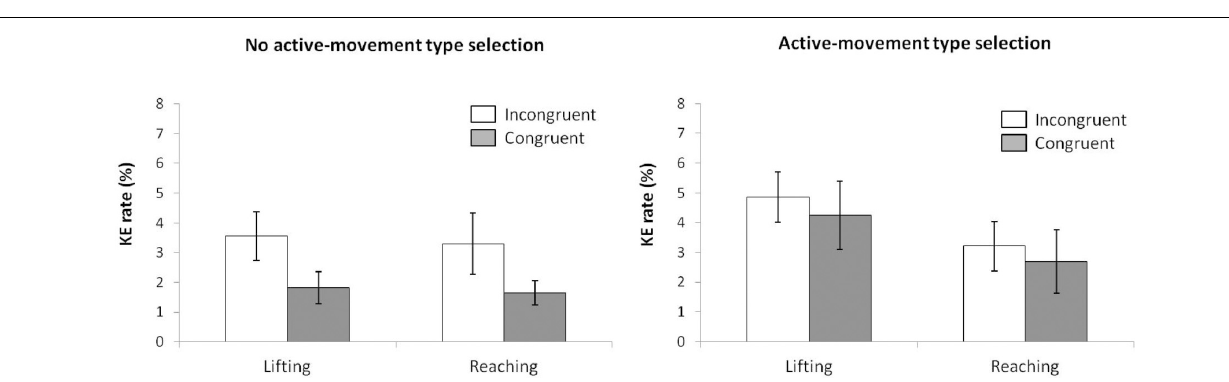
= 0.088, with a larger KE rate for p < 0.001, η 2 p